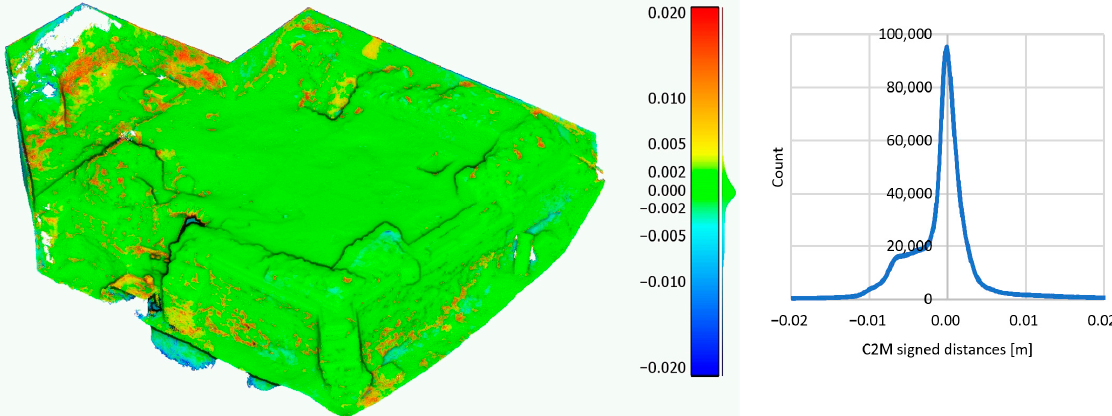
Figure 15. Deviations in the comparison of photogrammetry with all images active and the variant without connection through opening 2 (A vs. D) ( left ), and histogram of the deviations ( right ).